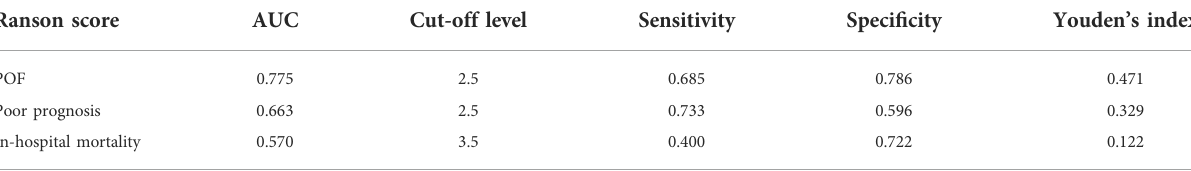
TABLE 7 ROC curve analysis of Ranson score in 82 AP patients. Ranson